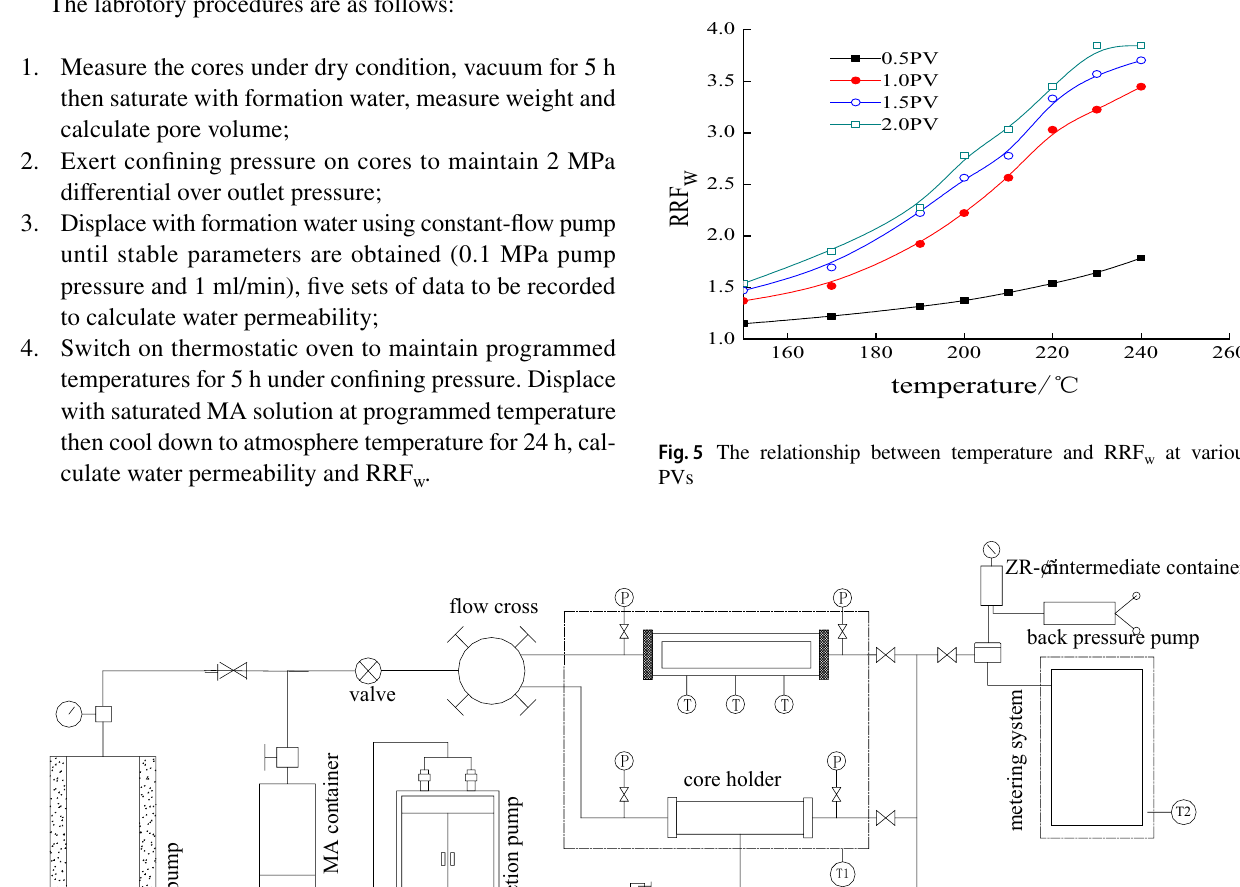
Fig. 4 A full view of the experimental system